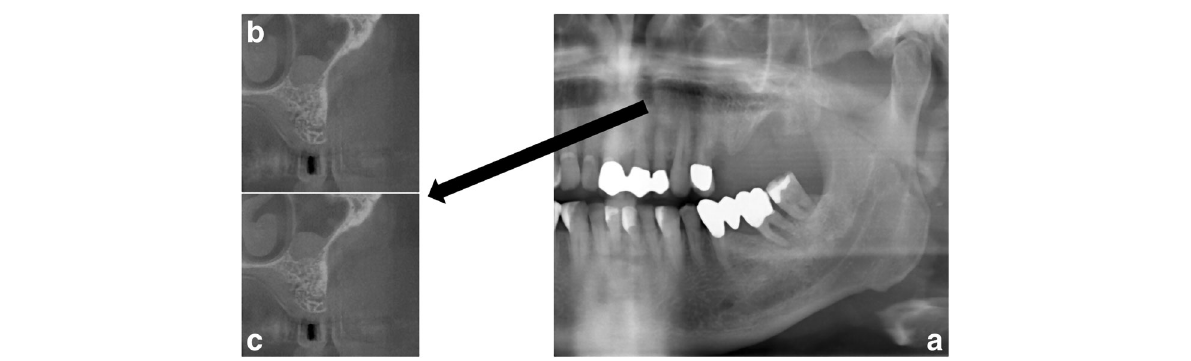
Fig. 2 a Panoramic radiography with area of interest (maxillary sinus) and b , c examples of corresponding images in cone beam computed